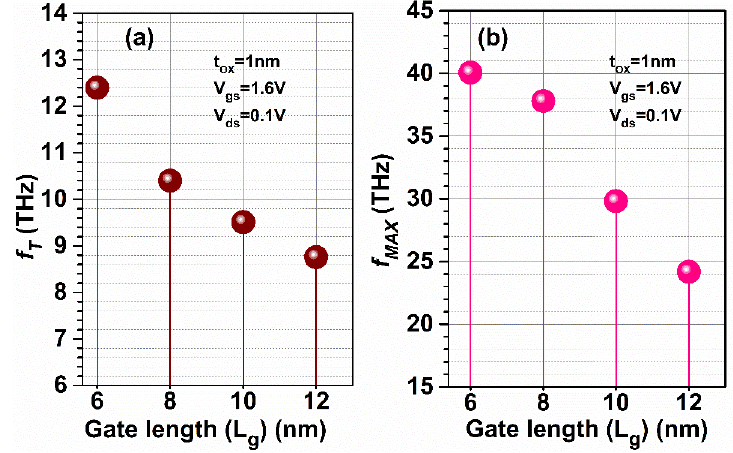
Figure 12. ( a ) f T and ( b ) f MAX at various gate lengths of GaN-SOI-FinFET.